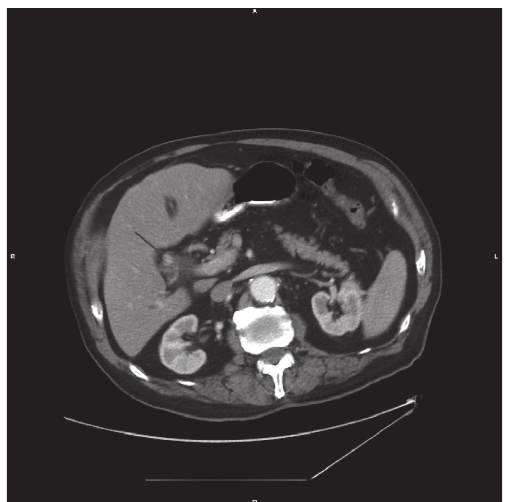
Figure 3: Axial CT of the abdomen with contrast demonstrates intrahepatic biliary dilatation.